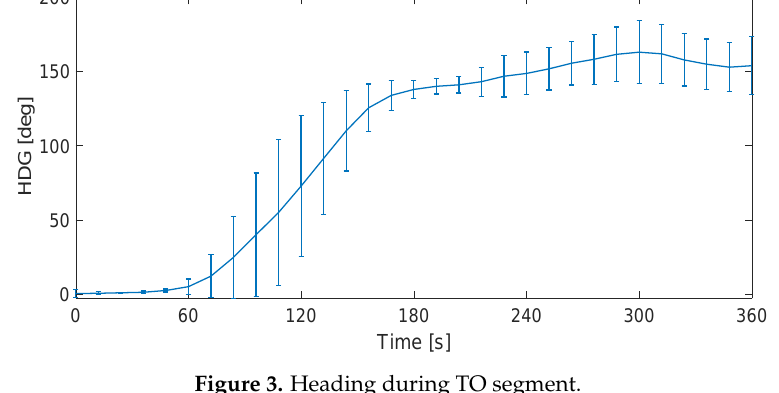
Figure 3. Heading during TO segment.